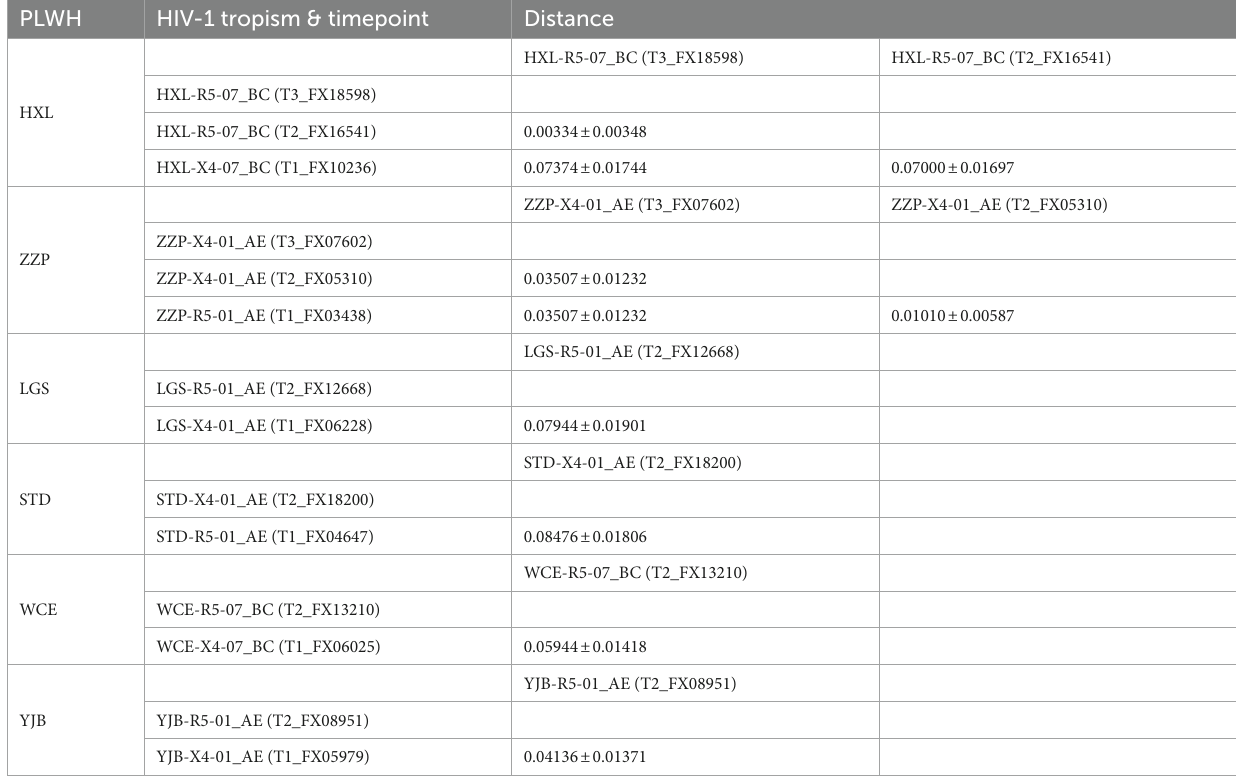
TABLE 6 Estimates of env-c2v3 evolutionary distance within individual sequences. PLWH HIV-1 tropism &